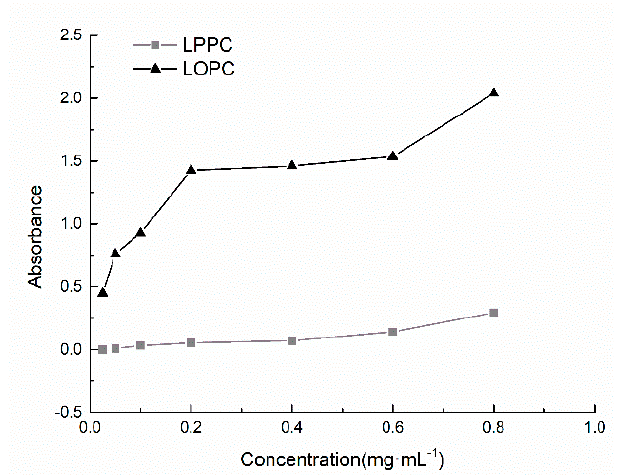
Figure 5. Comparison of reducing power of proanthocyanidins with different mass concentrations.